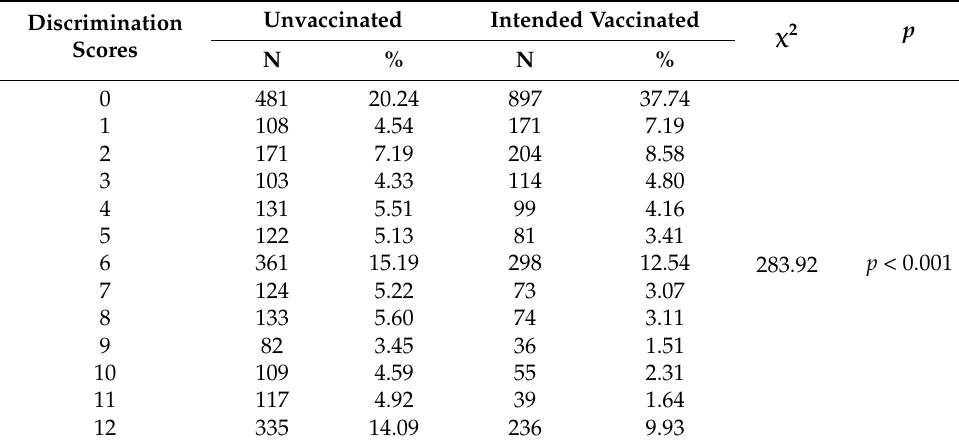
Table 3. Discrimination scores between unvaccinated and intended vaccinated